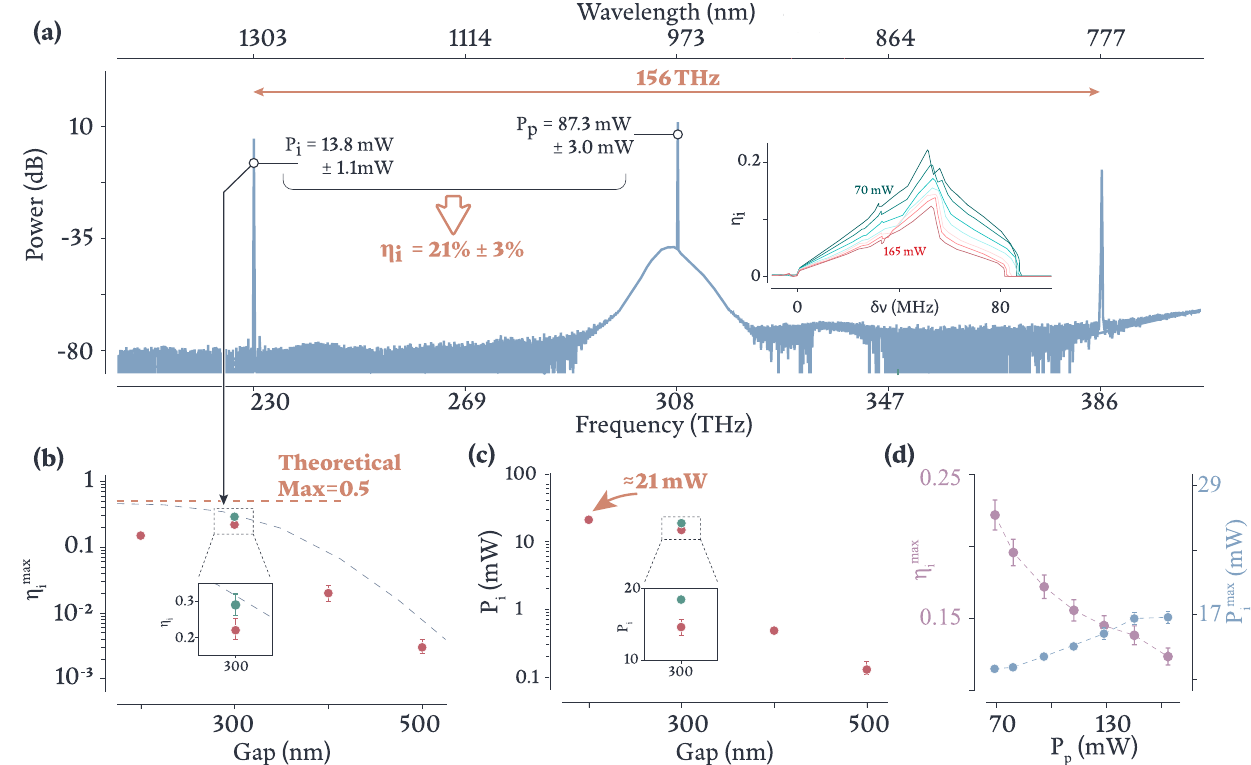
parameters extracted in Fig. 2 c , and the dashed orange line is the absolute theo- retical maximum, where 50% of the pump photons are converted to the idler and the other50% areconverted to the signal. Two differentdatapointsare shown ata gap of 300nm, corresponding to different OPOs. The OPO spectrum from the greendatapointin c isshowninFig.4( b )andrepresentsthehighest η i =0.29±0.04 with corresponding P i =(18.3±2)mW that we have observed. The uncertainty values and error bars in b – d are one standard deviation values and are due to the combined uncertainty of coupling losses on and off of the chip and the transmis- sion losses ofdifferent opticalcomponentsbetween the output coupling fi berand the detector (see Methods for details). For visual clarity, when the error bars are smaller than the data point size, they are